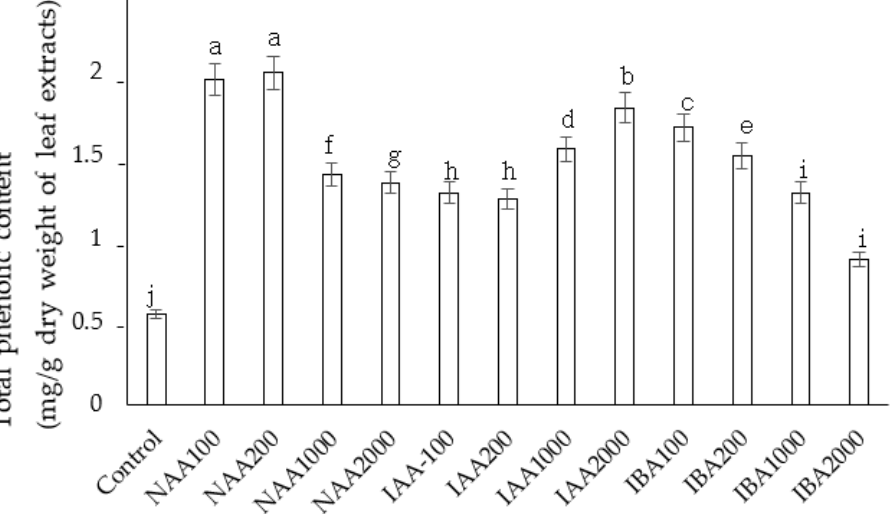
Figure 7. The effect of auxin concentration on total phenolic content in C. indicum . Values are reported as mean ± standard deviation of three parallel experiments. Different letters indicate statistical differences as assessed by Duncan’s multiple comparison tests ( p < 0.05).